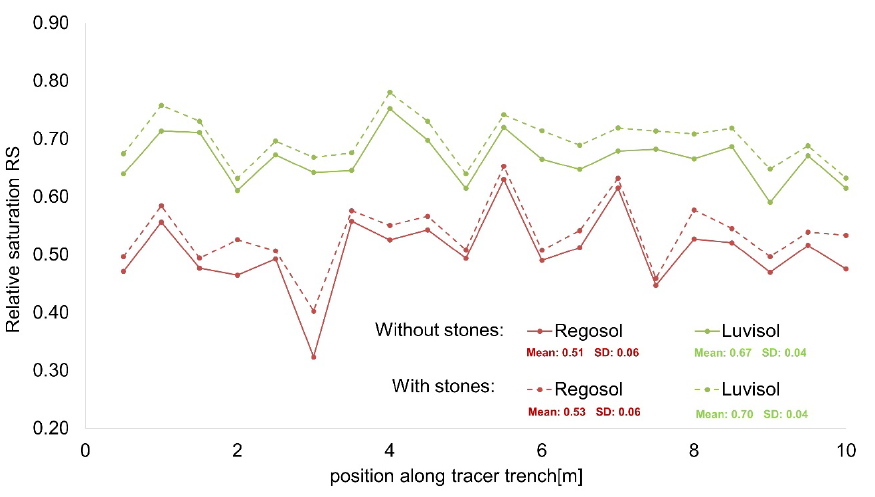
Figure 4. Relative saturation along the tracer application trenches of the Luvisol (LP12) and the Regosol (LP7).